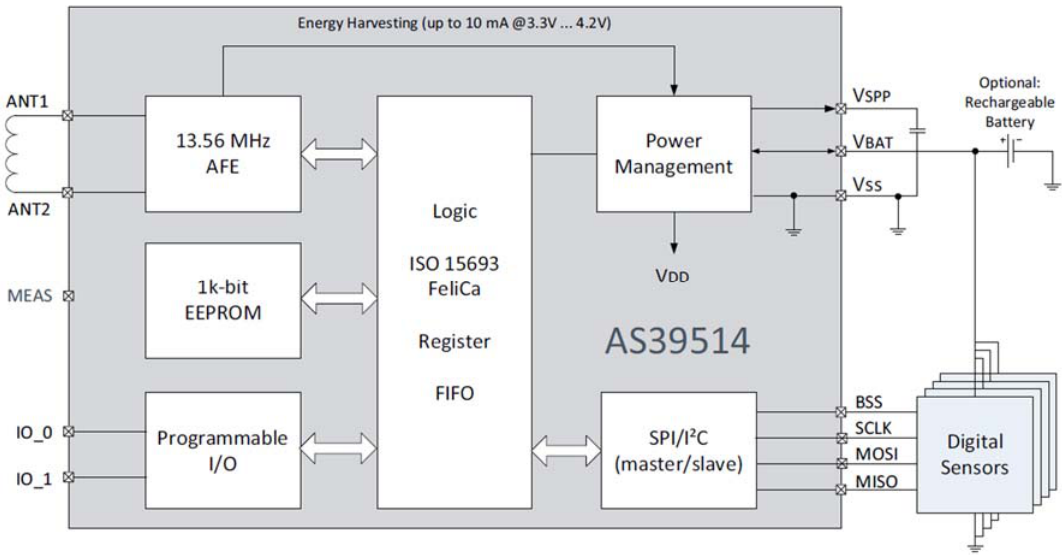
Figure 1. AS39514 passive tag IC block schematic.